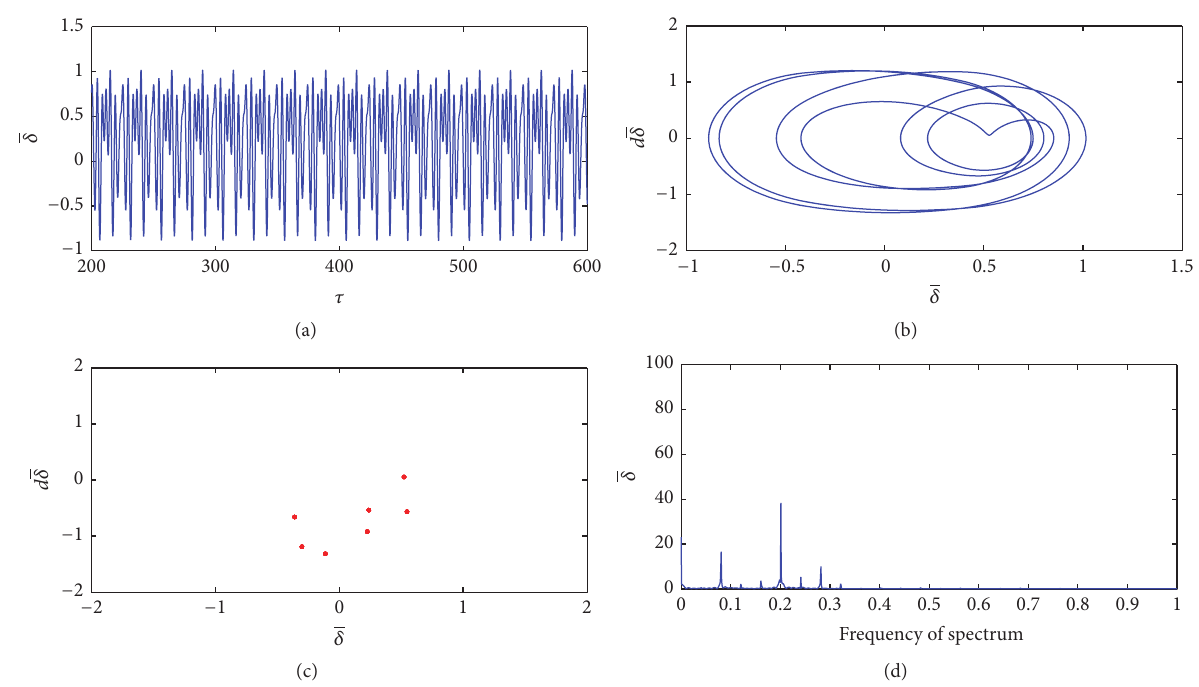
Figure 5: 𝜔 ℎ = 1.77: (a) time history; (b) phase plane; (c) Poincar´e map; (d) Fourier